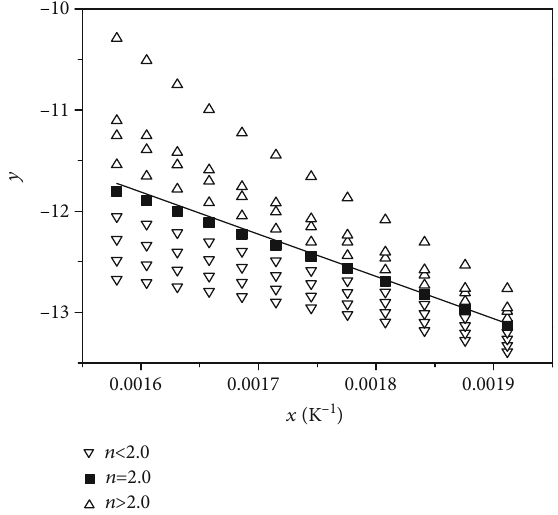
Figure 5: Coal tar combustion kinetic characteristics at 250 ° C-